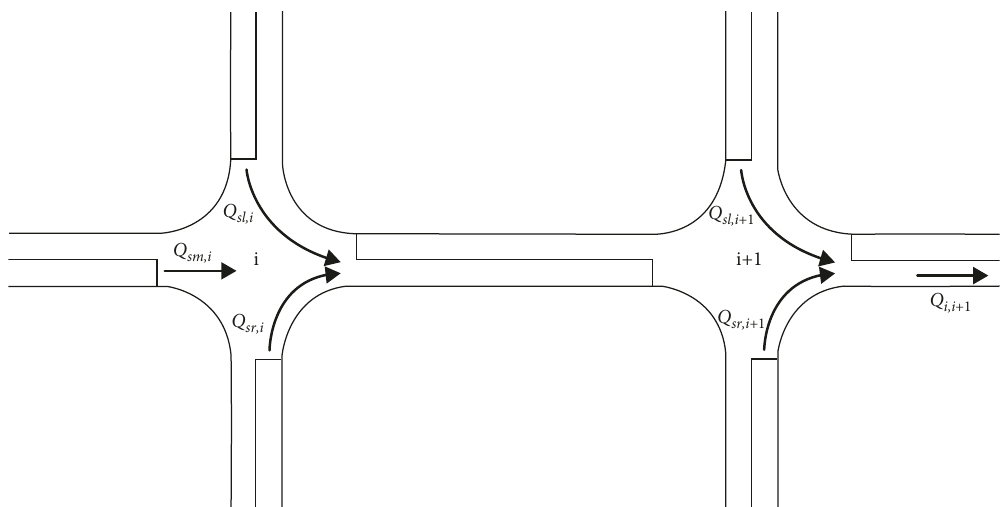
Figure 1: Schematic diagram of the traffic flow distribution at adjacent intersections. Table 1: Intersection merge threshold